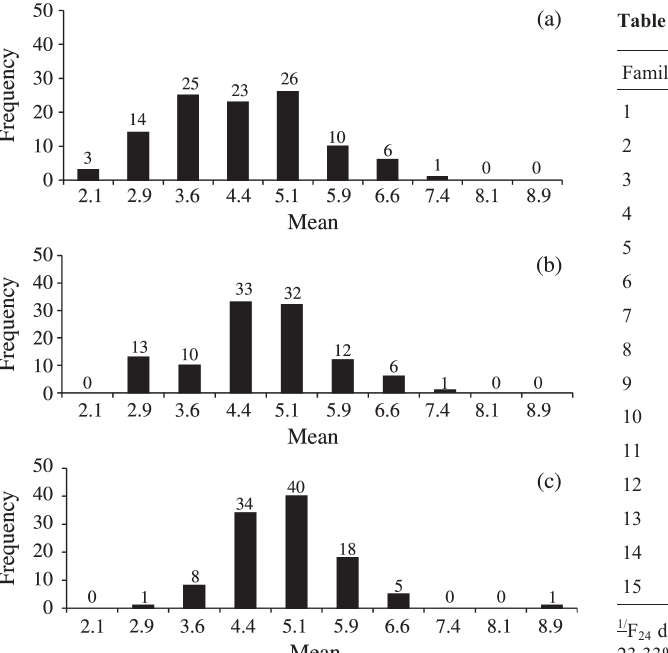
$ σ 2 ) and in joint analysis (Cov G Fi